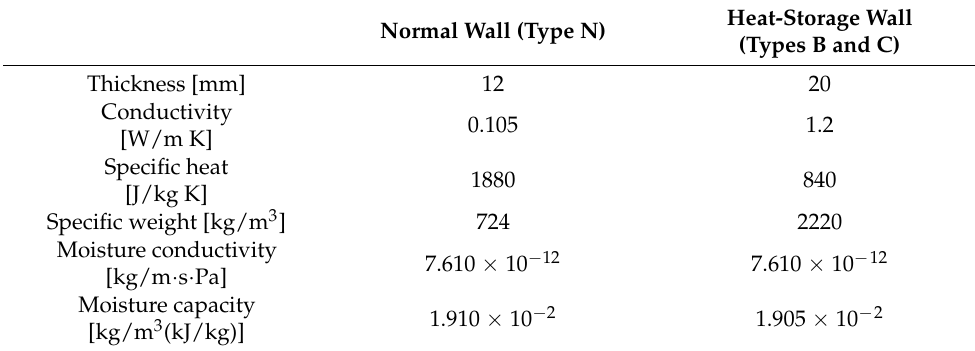
Figure 4. Air circulation route of Type B: ( a ) heat collection operation during daytime; ( b ) heat release during nighttime. Table 1. Thermal properties of normal indoor wall (Type N) and indoor heat-storage wall (Types B and